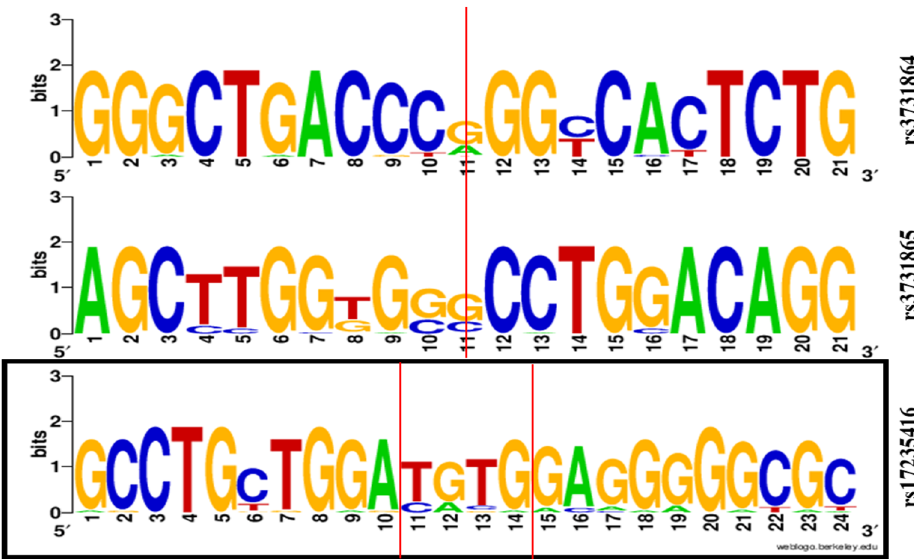
Figure 4. Illustration of sequence conservation. WebLogo illustrated the conservation of the DNA sequences around SLC11A1 –rs3731864 G/A, –rs3731865 G/C, and –rs17235416 + TGTG/− TGTG variations loci. The red vertical line indicates the positions of the variants loci in humans and the conservation of wild alleles across multiple mammalian species. The high nucleotide symbols indicate more conservation, while the small and more diverse ones show less